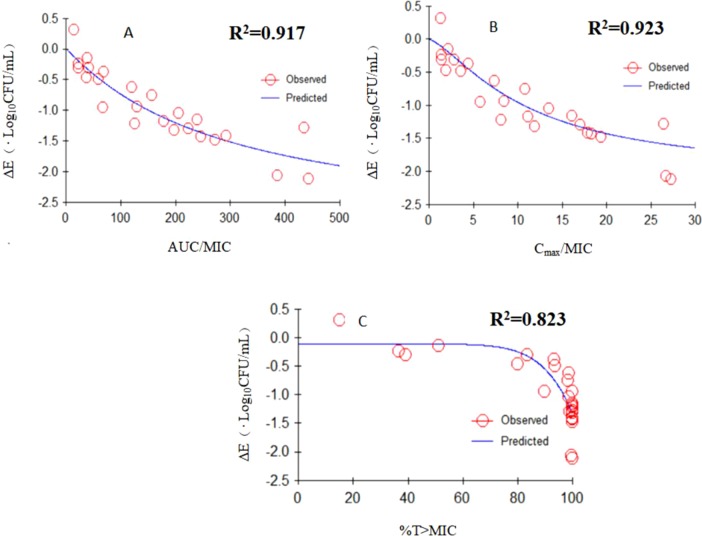

E
max relationships for the three PK/PD parameters versus antimycoplasmal effect. (A) AUC24 h /MIC; (B)
C
max/MIC; (C)
T > MIC.